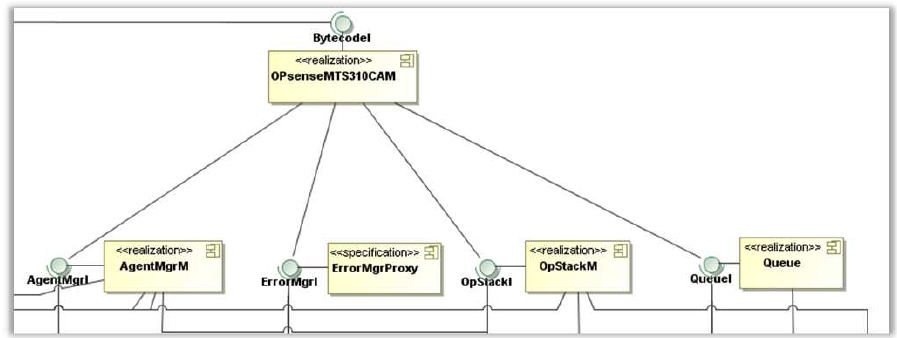
Figure 6. Agilla OPsenseMTS310CAC component model and relation of its required